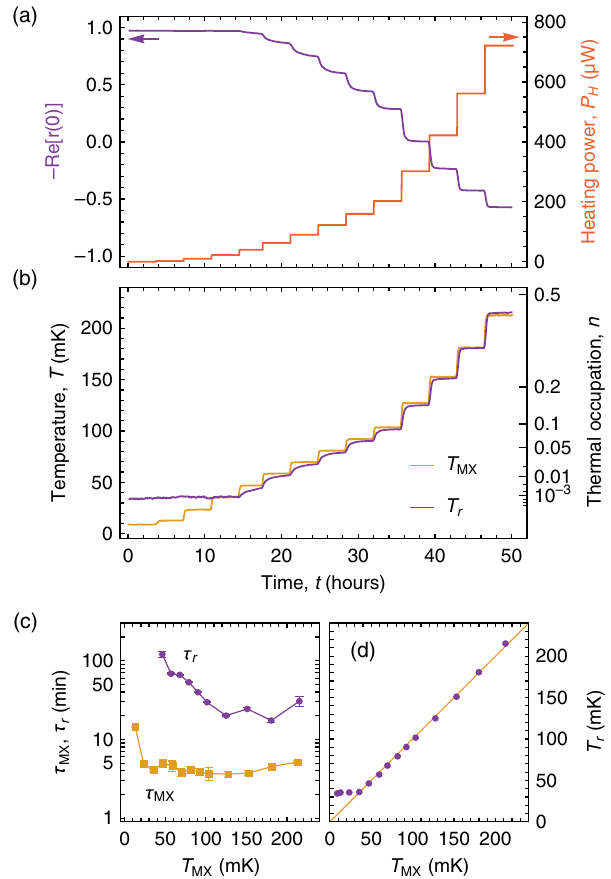
FIG. 4. Radiation-field thermometry while varying the temper- ature of the base plate. (a) Temporal profile of the heating power, P (right axis, red) used to vary the base-plate temperature T , H MX and corresponding temporal variation of the real part of the reflection coefficient (left axis, purple). (b) Corresponding base- plate temperature T (yellow) and radiation-field temperature MX T (purple) versus time. (c) Thermal relaxation constants τ r MX (squares) and τ (circles) for T and T , respectively, extracted r MX r from the data in panel (b) and plotted versus the steady-state T . MX The solid lines are guides for the eye. (d) Steady-state values of T r ¼ T versus T (circles); the solid line indicates T MX r MX